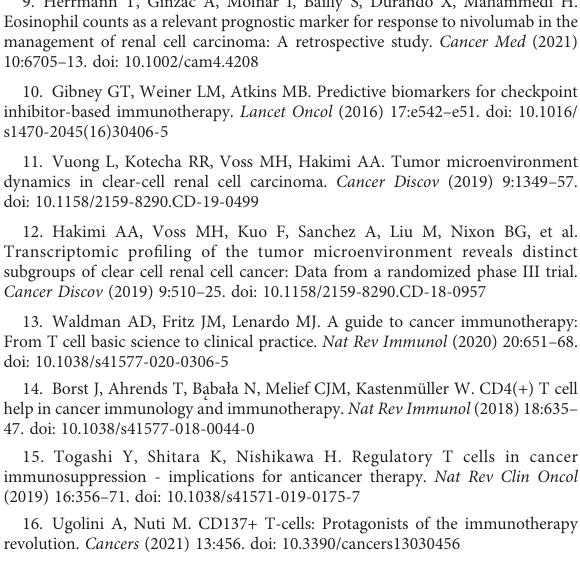
and those without any TRAE. SUPPLEMENTARY TABLE 4 Immune cell in fi ltration densities between patients with grade 3 hyperglycemia and those without grade ≥ 3